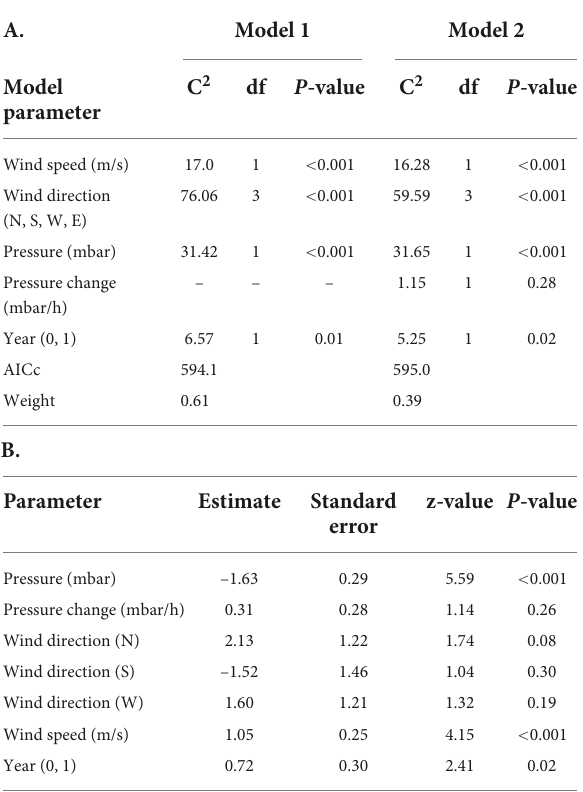
TABLE 2 (A) Top models and their corresponding parameters as selected by AIC model selection, predicting Semipalmated Sandpiper departures from the Bay of Fundy based on weather conditions. Only models with delta AICc values < 2 are presented. Weight represents the relative likelihood of a model. (B) Standardized model-averaged coefficients showing conditional averages for parameters from the top models. In the model year was coded as 0 for 2013 and 1 for 2014.